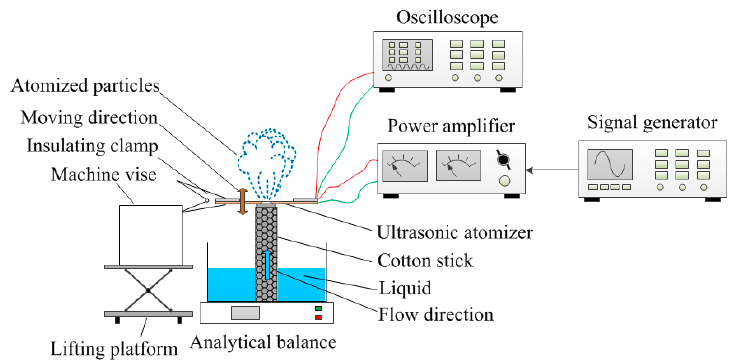
Figure 5. Schematic of the atomization rate measurement.